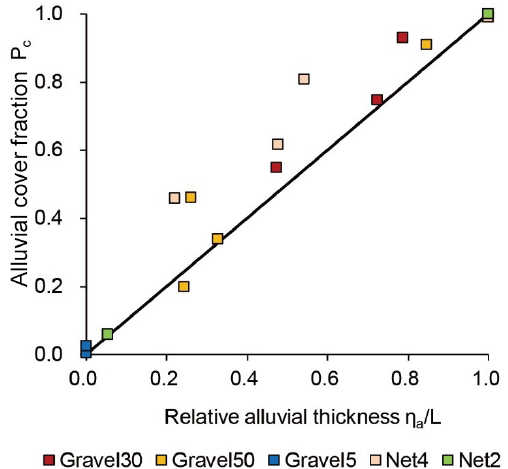
Figure 8. Relationship between relative gravel layer thickness and alluvial cover. The black line represents the 1/1